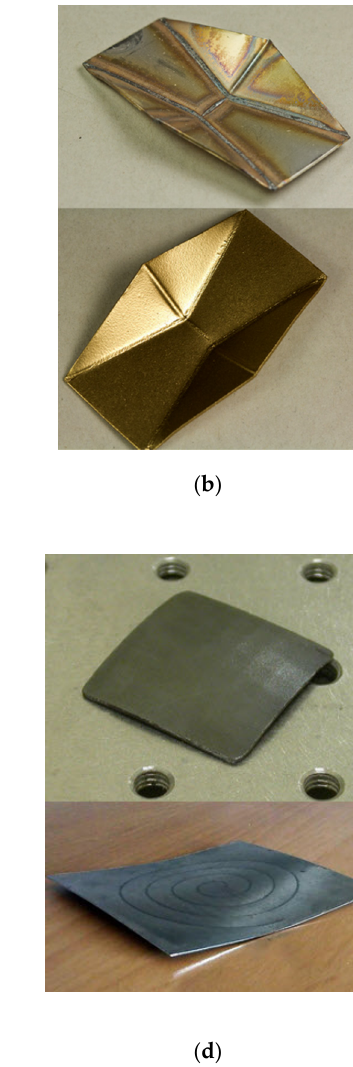
Figure 4. ( a ) Fabrication of a bowl shaped surface by laser forming [92], (Adapted from [92], with permission from Elsevier, 2020). ( b ) Origami Spoon [73], (Adapted from [73], with permission from Elsevier, 2020) ( c ) pillow, and warped shape [99], (Adapted from [99], with permission from Elsevier, 2020). ( d ) dome and saddle shaped surfaces [76,95]. (Adapted from [95], with permission from Elsevier, 2020)